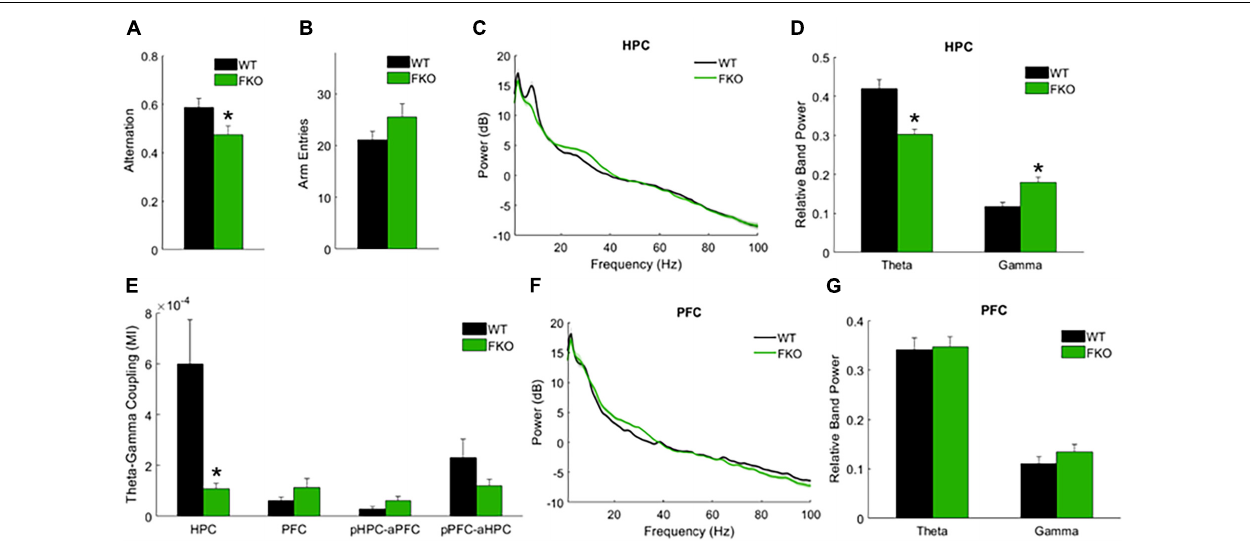
FIGURE 3 | Task-related neural oscillations in WT ( n = 12) and 14-3-3 FKO mice ( n = 14). Y-maze spontaneous alternations were significantly decreased in FKO mice (A) , indicative of spatial reference memory impairment. There is no significant difference between WT and FKO mice in the number of arm entries during the Y-maze (B) . During Y maze testing, HPC theta power is reduced and HPC gamma power is elevated in the FKO mice (C,D) . HPC theta-gamma coupling was decreased in FKO mice (E) . No significant differences were observed in PFC power between WT and FKO mice (F,G) . Statistical significance denoted as * p < 0.05. MI, modulation index. pHPC, HPC phase. aPFC, PFC amplitude. pPFC, PFC phase. aHPC, HPC